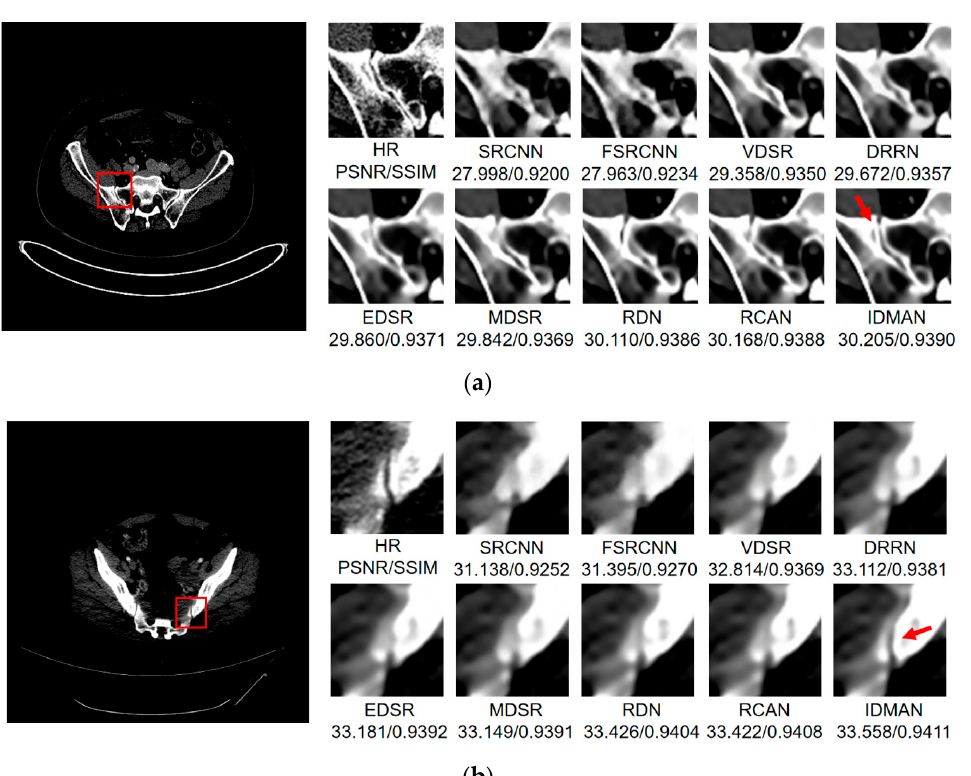
Figure 10. Images ( a , b ) show the visual results of different algorithms on DeepLesion testing set for scaling factor × 4